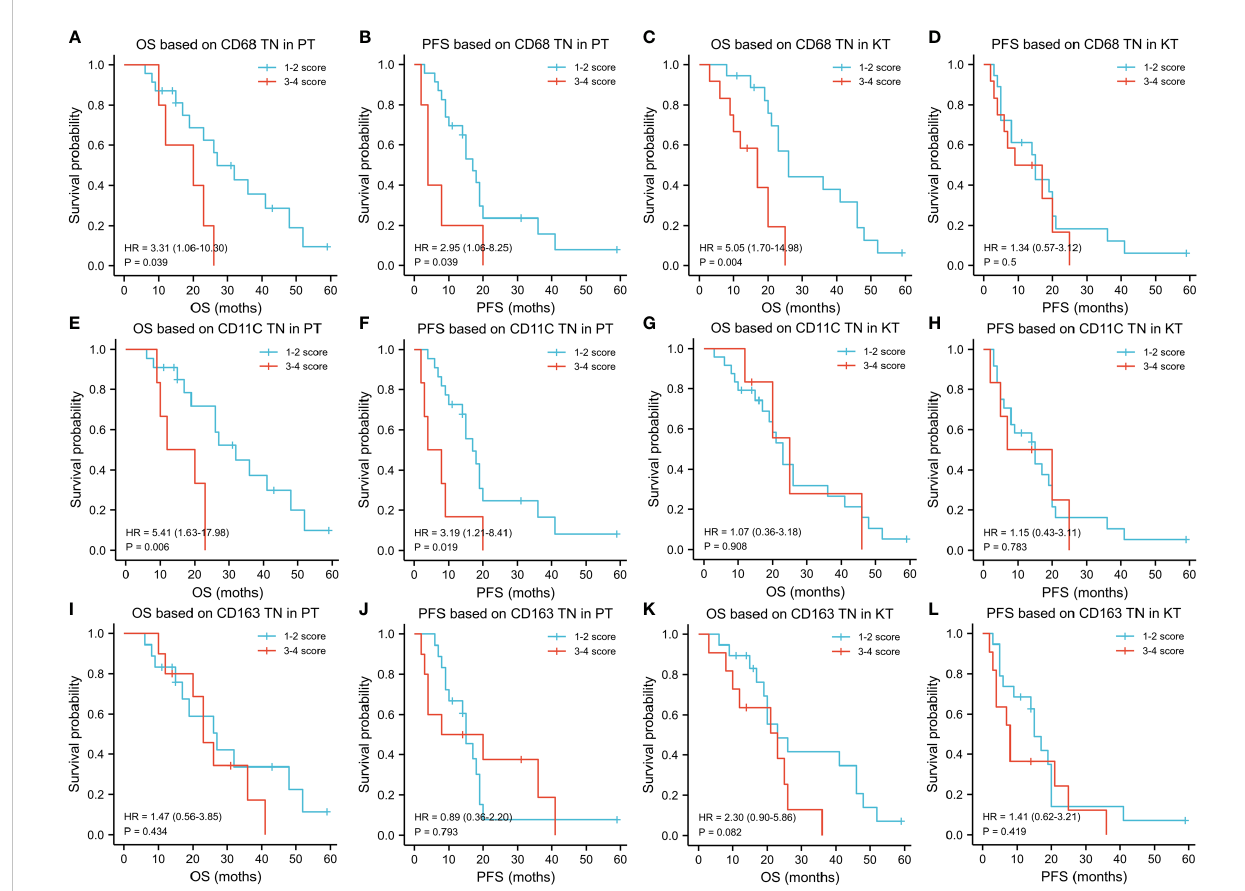
FIGURE 6 In fl uence of the level of in fi ltration of TAMs in tumor nest on prognosis of patients with KTs. (A-L) Kaplan – Meier analysis was used to explore the prognostic value of the in fi ltration of TAMs in the tumor nest region and different areas of primary tumors and KT tissues for OS and PFS. Regarding the tumor nest region of primary lesions, patients with KTs with high in fi ltration of CD68+ and CD11C+ TAMs had worse OS and PFS, whereas CD163+ TAMs had no signi fi cant effect on OS and PFS. Regarding the tumor nest region of KT tissues, the level of in fi ltration of CD68+ TAMs was related to the OS of patients but not to the PFS. No effect of the number of CD11c+ and CD163+ TAMs in the tumor nest of KTs on prognosis was